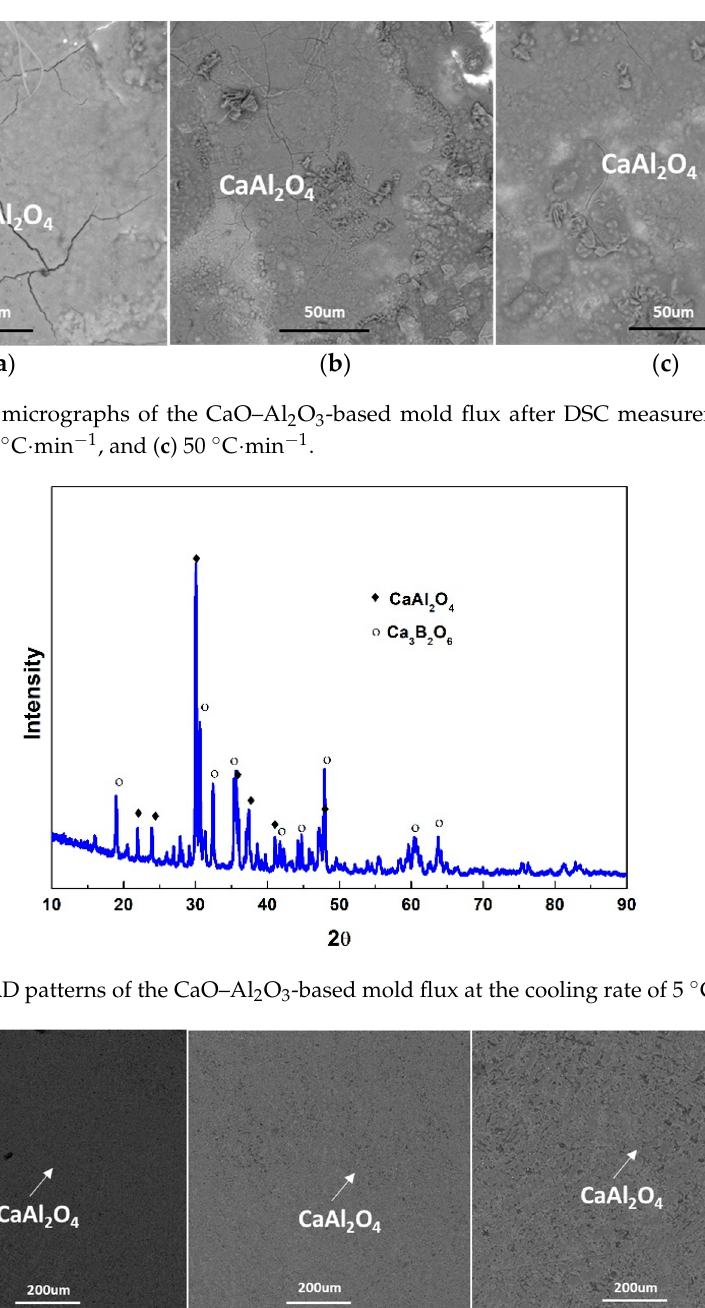
Figure 11. XRD patterns of the CaO–Al 2 O 3 -based mold flux at the cooling rate of 5 °C·min − 1 .